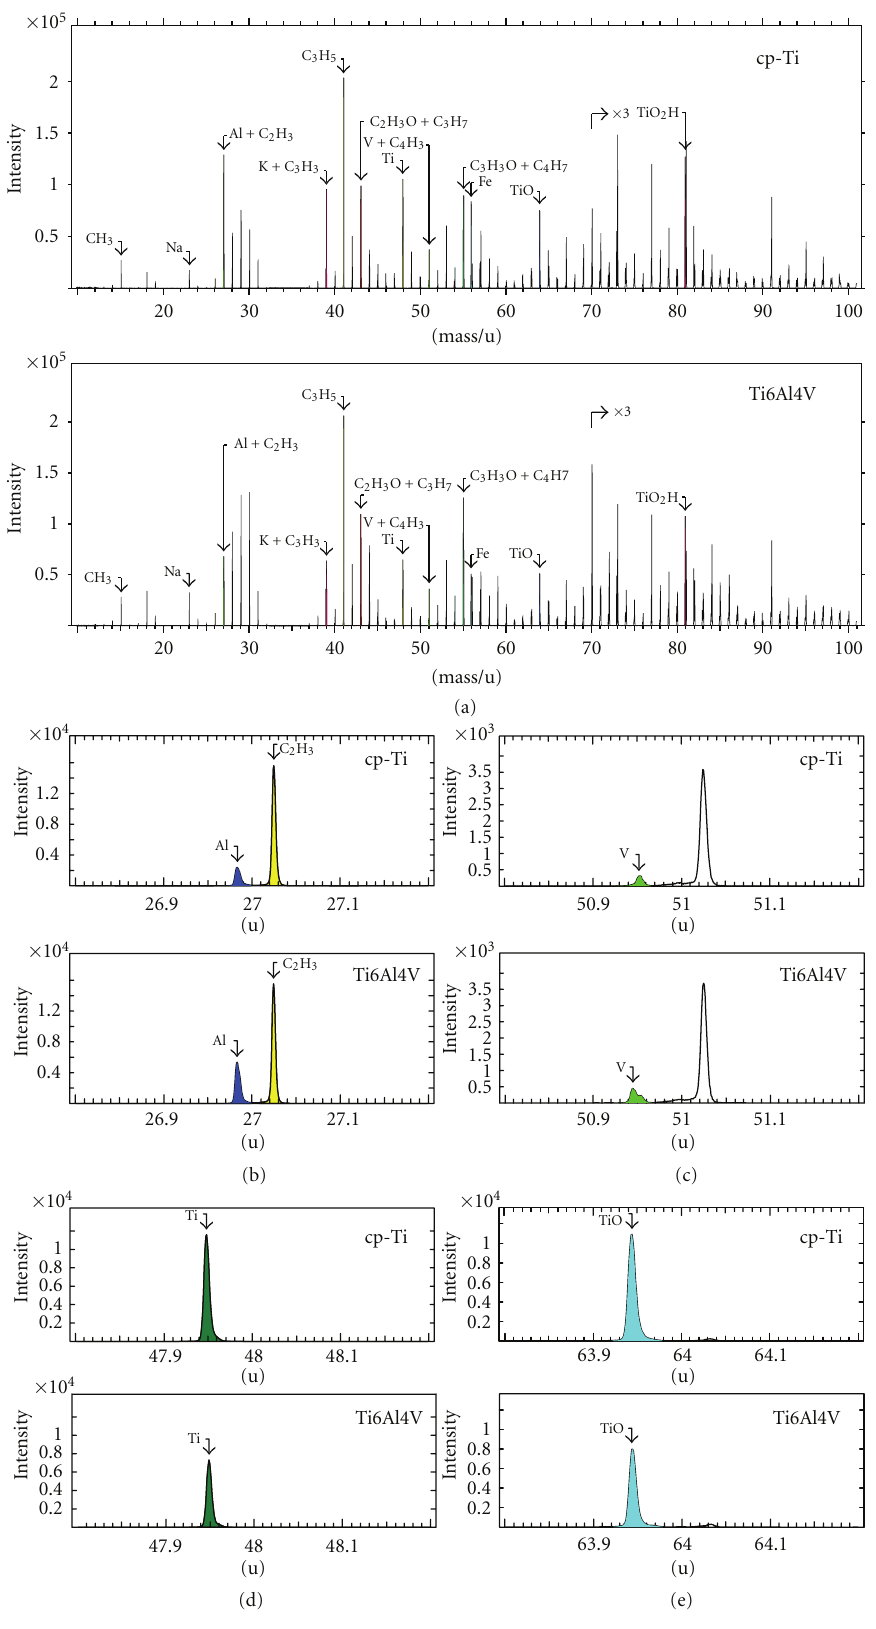
Figure 2: (a) TOF-SIMS spectra showing the elemental surface compositions of the cp-Ti and Ti6Al4V sca ff olds. Enlargements of the spectra displaying the Al + (b), V + (c), Ti + (d), and TiO + (e)